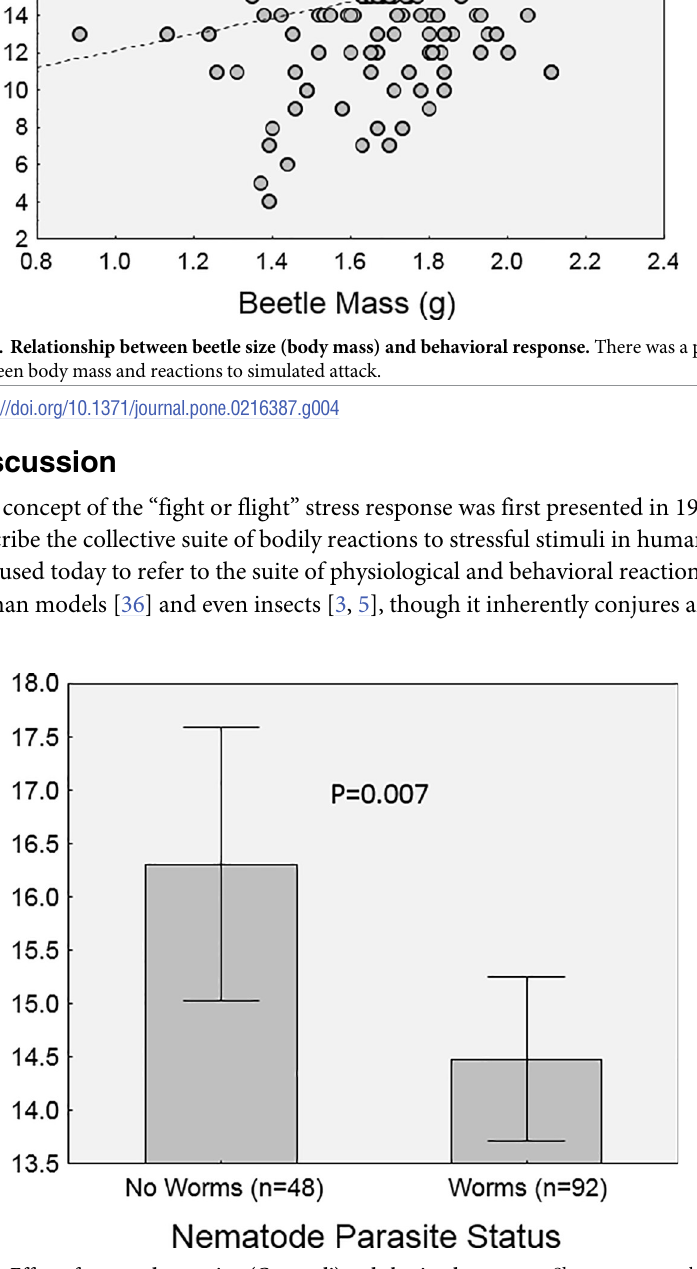
Fig 5. Effect of nematode parasites (C. passali) on behavioral responses. Shown are mean behavioral response scores (with 95% CI) of parasitized and non-parasitized beetles during simulated attack. Parasitized beetles had significantly lower reactions to simulated predator attack than beetles without